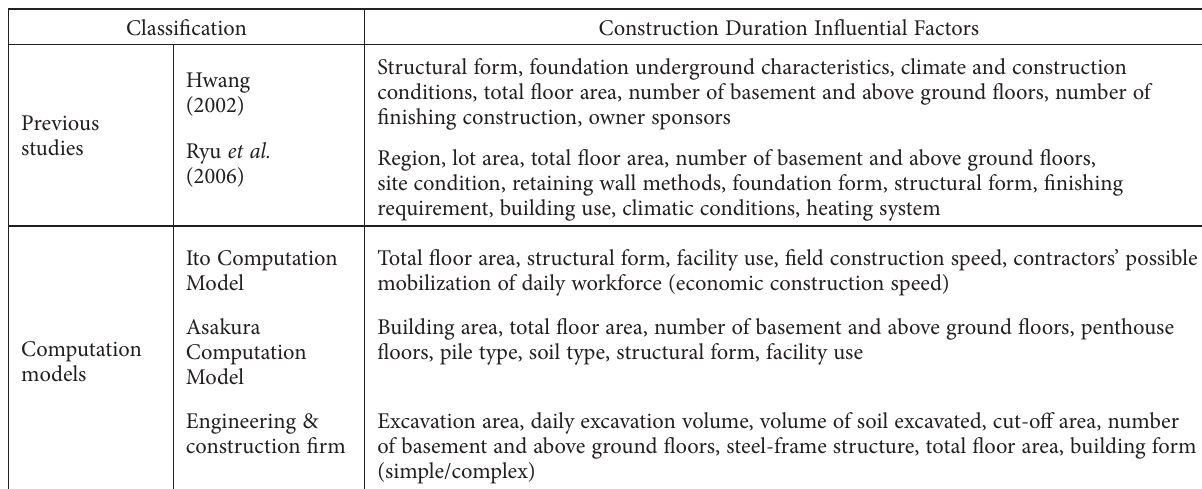
Table 3. Analysis of the influential factors for office buildings construction duration computation Classification